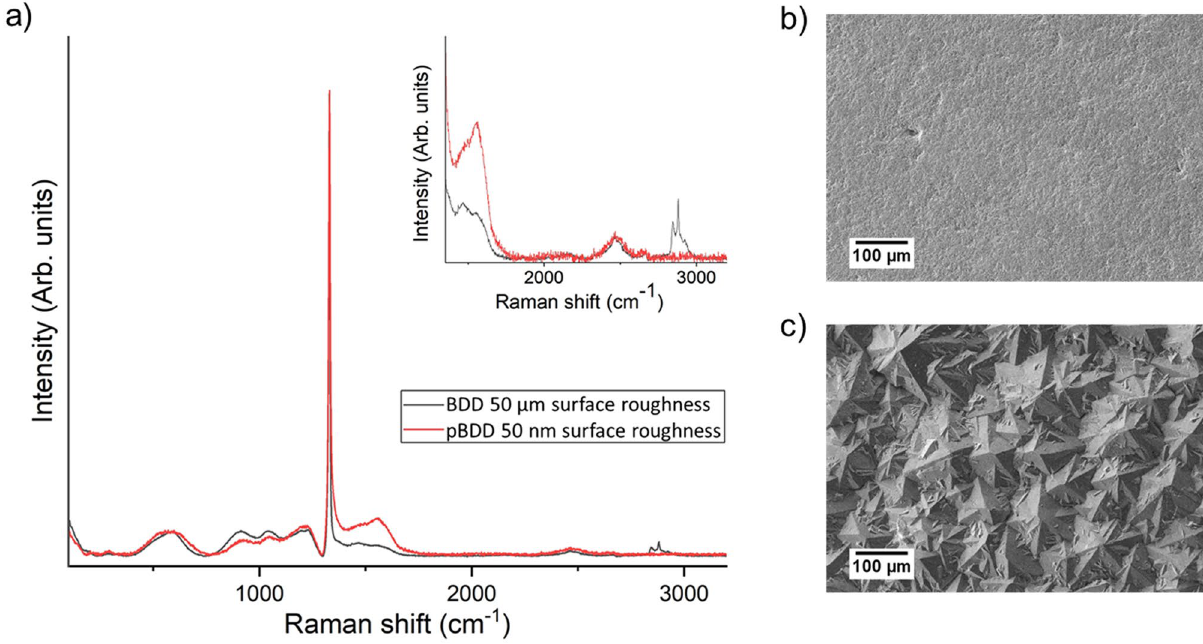
Figure 1. (a) Raman spectra of the unpolished BDD substrate revealing the distinctive 1332 cm -1 peak of the diamond carbon phase, and (inset) second order Raman spectrum (black) and similar measurements for the polished pBDD substrate (red), with the corresponding SEM images of (b) the BDD substrate and (c) the polished pBDD substrate.